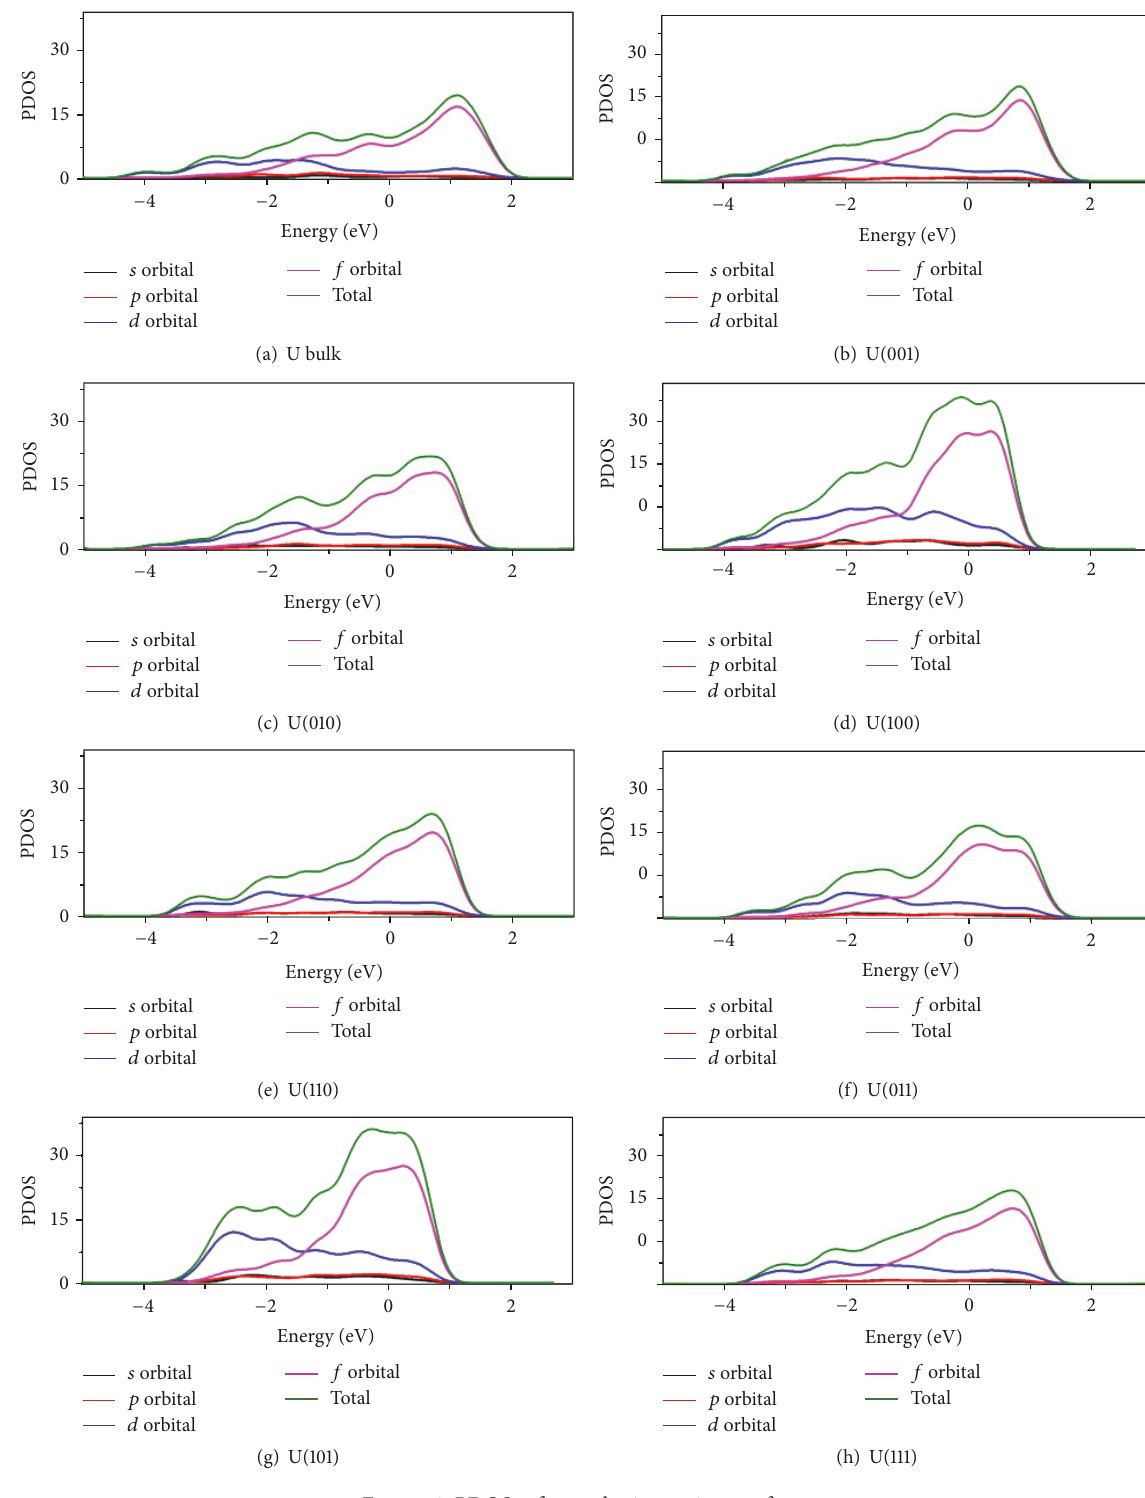
Figure 8: PDOSs of seven basic uranium